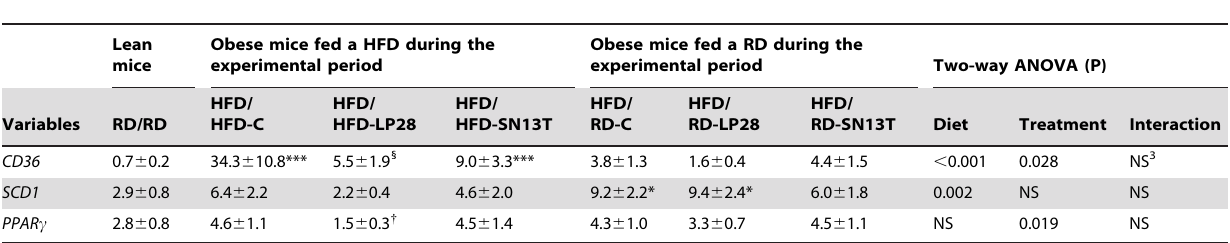
1 Data are mean 6 SE, n=5. 2 The data are expressed relative to GAPDH mRNA. 3 NS, Not significant. * P ,